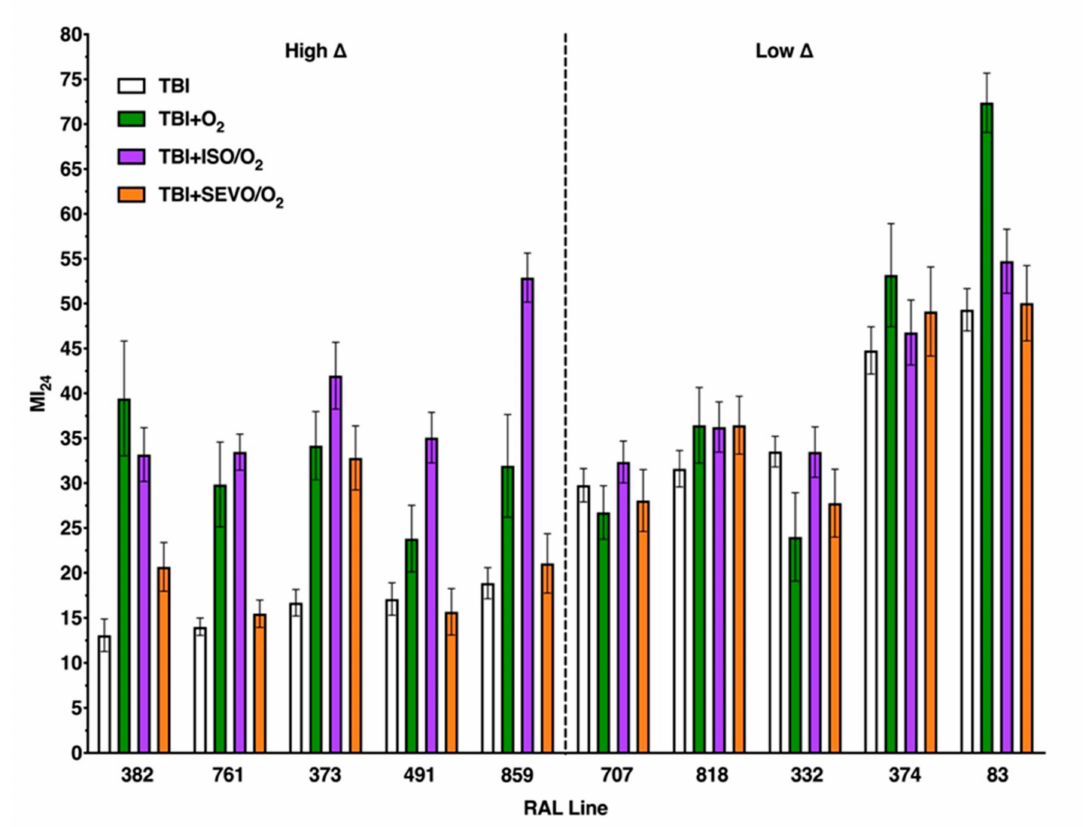
Figure 1. Genetic background alters the e ff ect of exposure to O 2 , ISO / O 2 , or sevoflurane (SEVO) / O 2 on mortality 24 h after traumatic brain injury (TBI). Ten fly lines (RAL lines) from the DGRP collection, indicated by RAL line number, are arranged from left to right by increasing MI 24 from TBI. Exposure to ISO / O 2 increased the MI 24 of high ∆ lines (left) but not low ∆ lines (right). The ∆ mortality in percentage points between TBI alone and TBI with exposure ranged from 0 (RAL332 33.5 ± 11.1% vs. 33.5 ± 11.9%) to 34 (RAL859 18.9 ± 11.2% vs. 52.9 ± 11.6%) for ISO / O 2 ; from − 9.5 (RAL332 33.5 ± 11.1% vs. 24.0 ± 13.9%) to 26.3 (RAL382 13.1 ± 11.6% vs. 39.4 ± 18.1) for O 2 ; and from − 5.7 (RAL332 33.5 ± 11.1% vs. 27.7 ± 15.1%) to 16.1 (RAL 373 16.7 ± 9.8% vs. 32.8 ± 14.3%) for SEVO / O 2 . Bars represent the average MI 24 and standard deviation of at least three independent samples of 20 mixed sex flies each at 1–8 days